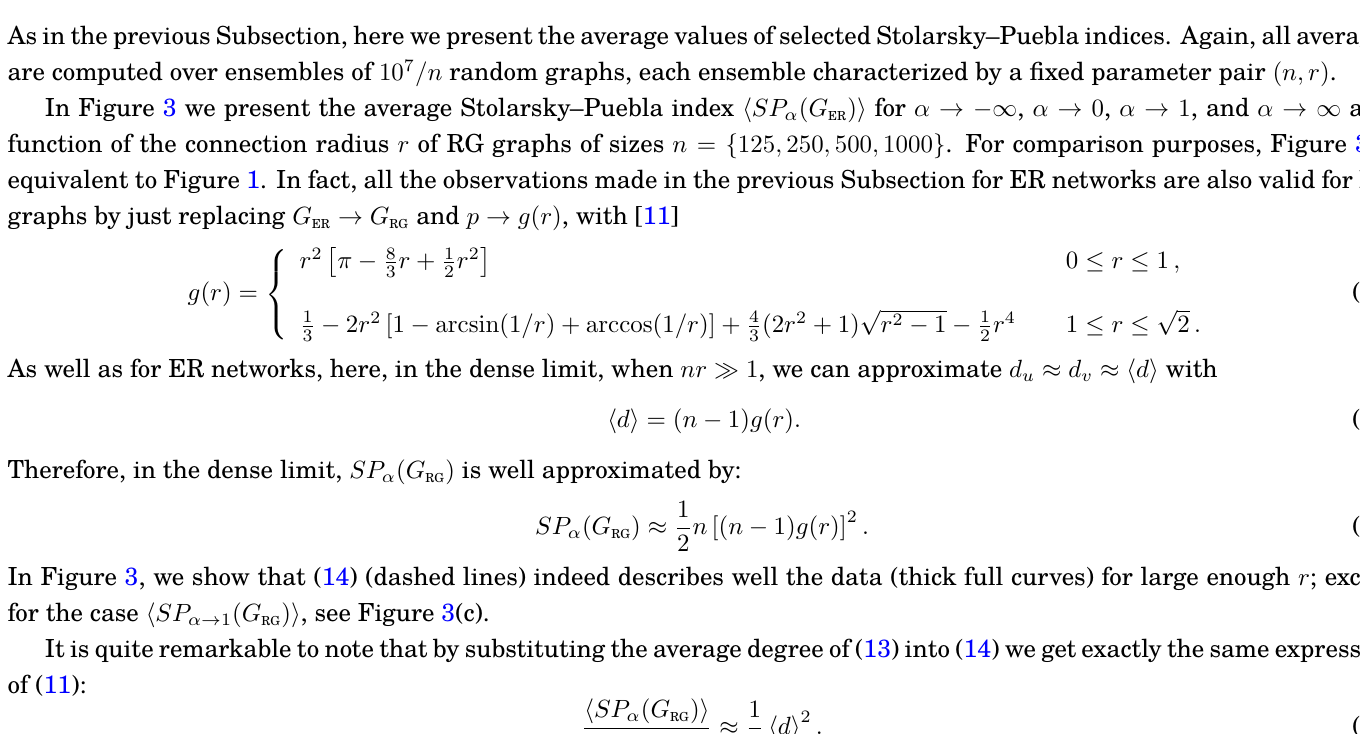
Figure 2: Average value of the Stolarsky–Puebla index (cid:104) SP the average degree (cid:104) d (cid:105) of Erd¨os-R´enyi networks. Same curves as in Figure 1. Orange dashed lines are (11). The vertical magenta dashed lines indicate (cid:104) d (cid:105) = 10